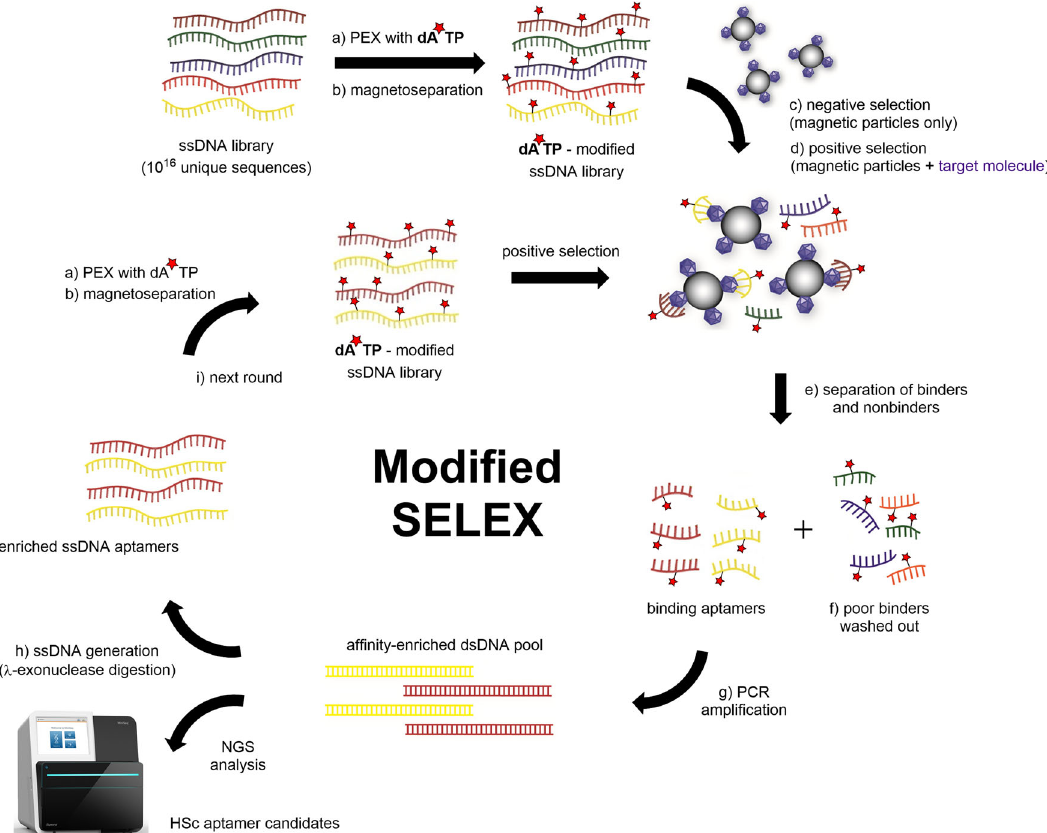
Fig. 3 Principle of the modi fi ed SELEX procedure used in this study (scheme modi fi ed from ref. 41 ). a The initial modi fi ed library is generated by PEX from 5 ′ -biotinylated ssDNA library followed by b single stranded generation via magneto-separation. c A counter-selection step against the beads was carried out prior to d positive selection with the target. e , f The bound ssDNA is separated from the non-binders by washing and g the released ssDNA is ampli fi ed by PCR using biotinylated forward primer and phosporylated reverse primer, which allows for h subsequent ssDNA generation via Lambda exonuclease digestion. i The resulting 5 ′ -biotinylated ssDNA is ready for PEX and another round of modi fi ed